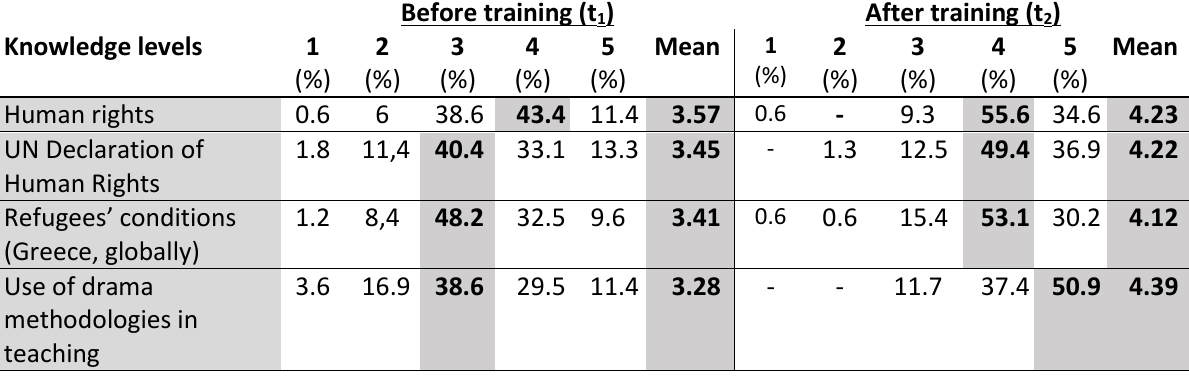
Βefore training (t 1